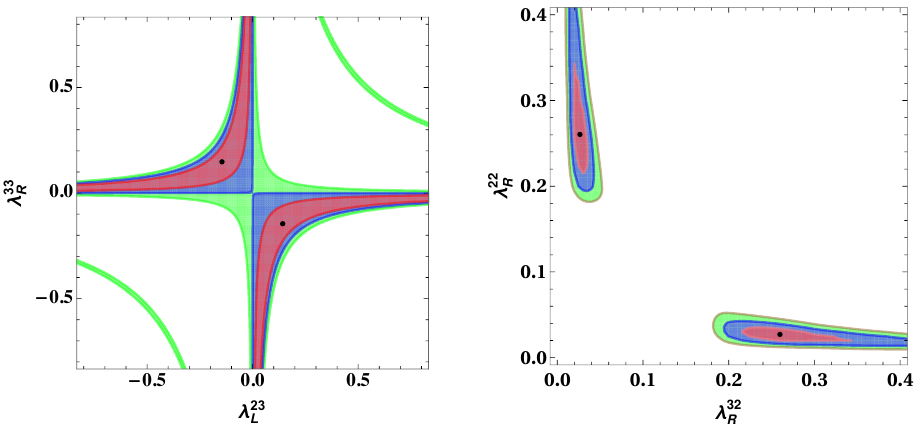
Figure 5 . Constraints on new LQ couplings from observables mediated by b → cτ ¯ ν (left panel) and b → sµ + µ − (right panel). Different colors correspond to 1 σ , 2 σ , and 3 σ contours and the black dots represent the best-fit value.